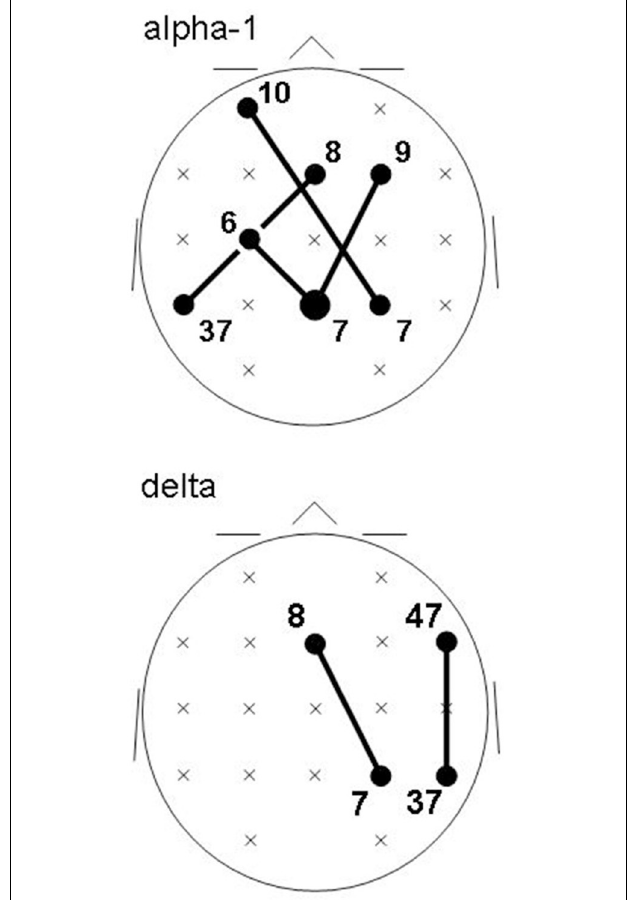
FIGURE 1 | Common intracortical connectivities differing between patients and controls in all three groups (lines) at non-corrected conjunction p < 0 . 001. Connectivities of the EEG alpha-1 frequency band (top) are decreased in patients; connectivities in the delta frequency band (bottom) are increased in patients. Head seen from above; semi schematic array of the 19 ROIs. Bubble sizes indicate how many connectivities anchored at each ROI (here, 1 or 2); crosses indicate ROIs where no connectivity anchored. Numbers indicate the Brodmann areas to which most of the voxels of a given ROI were assigned.